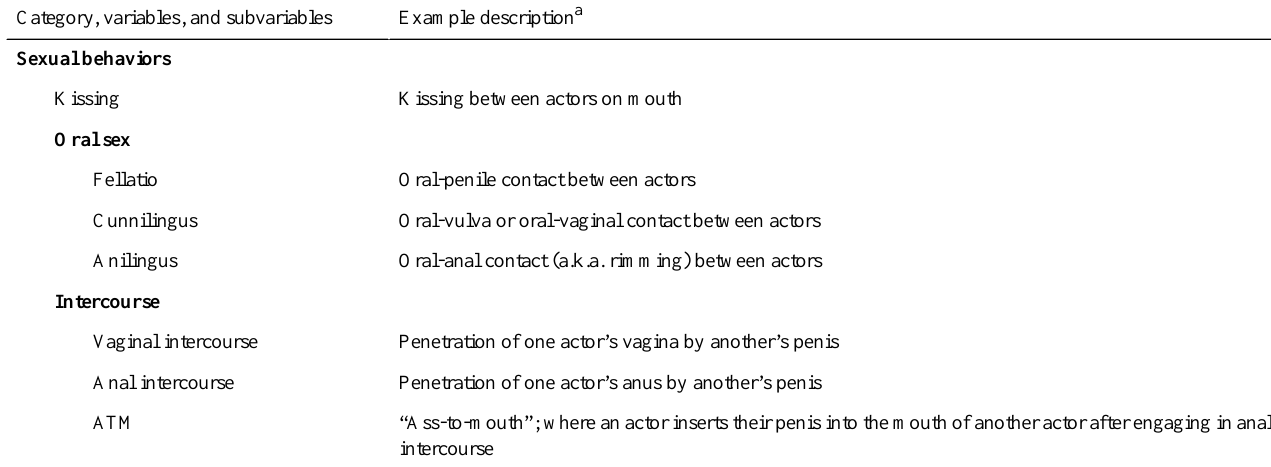
Example description a Category, variables, and subvariables